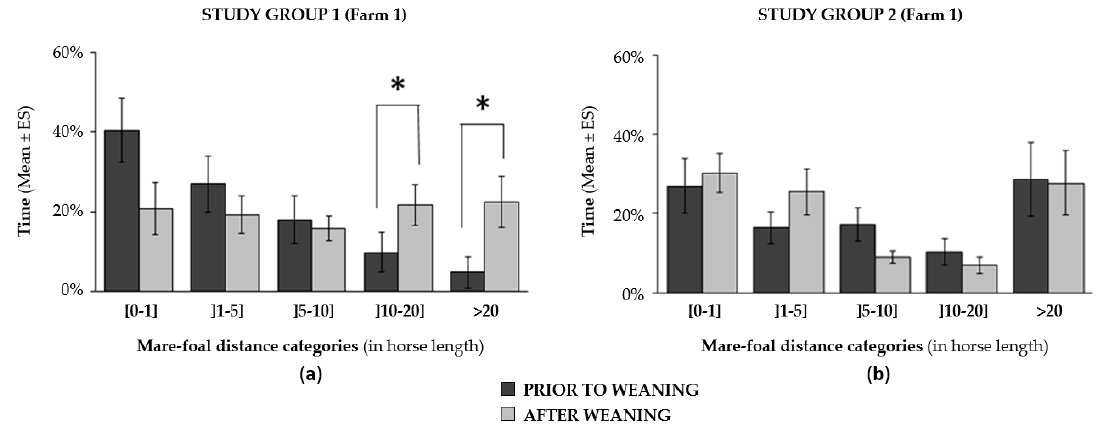
Figure 1. Change in the of mare–foal distance before and after weaning: ( a ) in study group 1; ( b ) in study group 2. Wilcoxon tests: * p < 0.05.